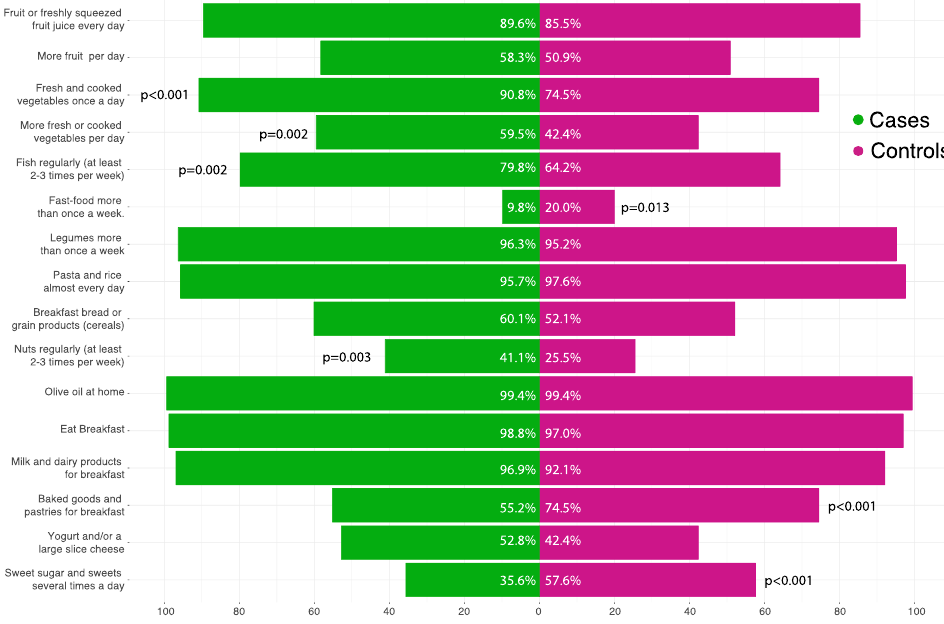
Figure 3. Longitudinal trajectories of KidMed score in children stratified by treatment arm. Results are expressed as Estimated Marginal Means (EMM) with the corresponding 95% Confidence Inter- vals (95% CIs). EMM’s were based on a linear mixed models using time as categorical factor.